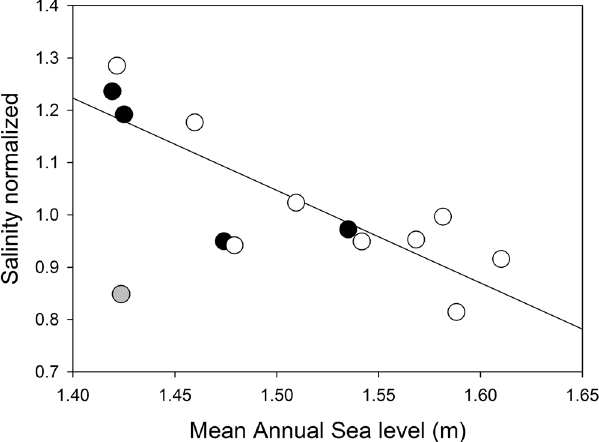
Figure 3. The relationship between normalized porewater salinity and the annual mean sea level over the study period. The regression, of the form y = 3.70 + − 1.77 * x, R 2 = 0.69, is significant either with or without the data for 2002 data included (indicated in grey) which was a year with intense rainfall in the month prior to sampling. Filled symbols are from 2002–2011 and open symbols from